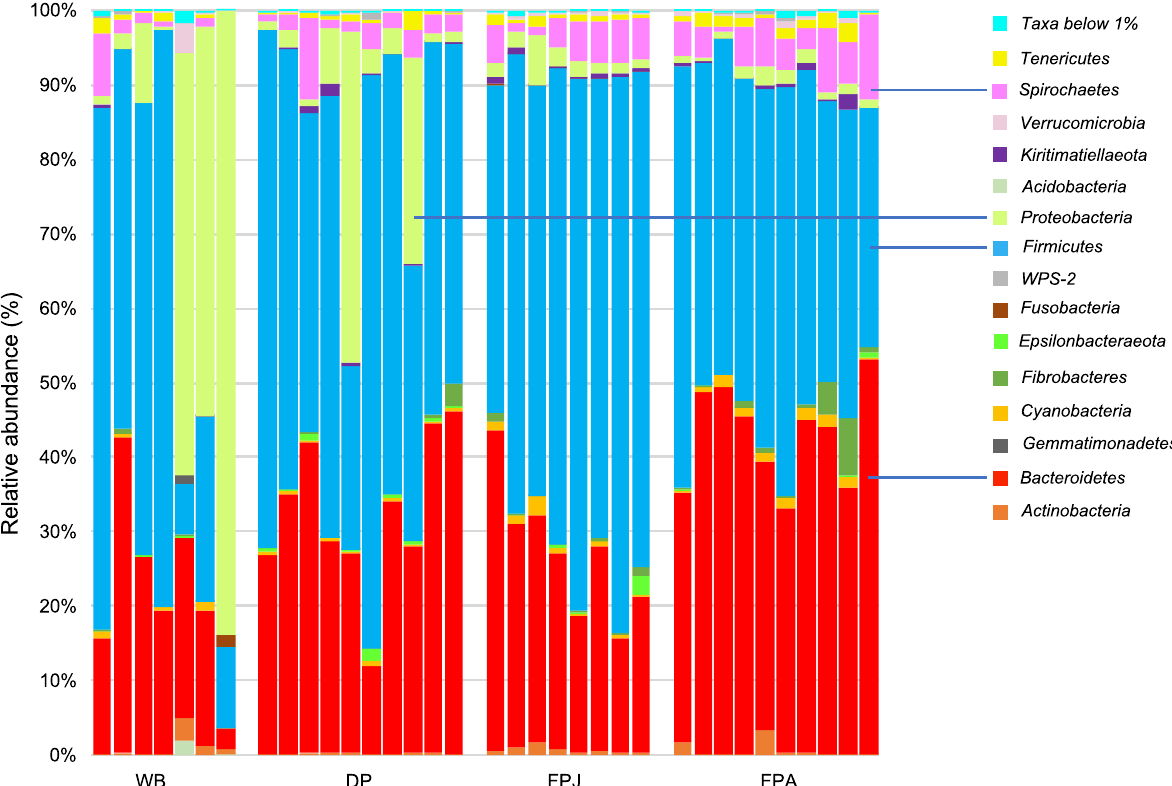
Fig. 1 Relative abundance (%) of phyla in each sample. The bars in the graph show the proportion of the sequences in each sample that can be classified at the phylum level. The blue lines indicate phyla that occur in at least one sample with a frequency of occurrence DP, domestic pig; FPJ, juvenile feral pig; FPA, adult feral